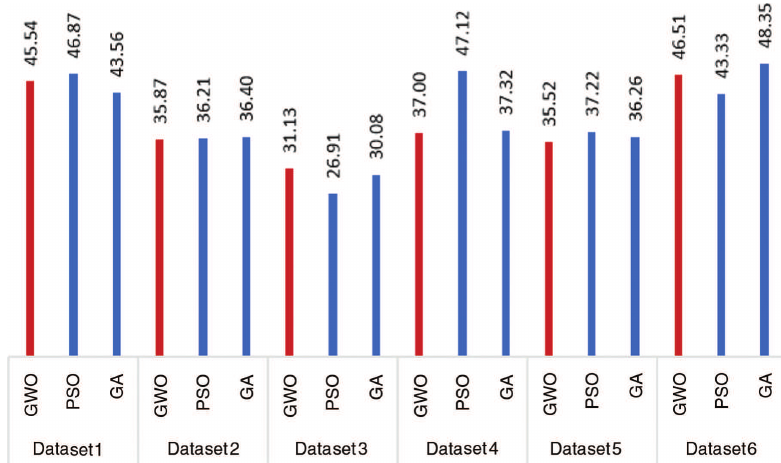
Figure 7: Results of Time Complexity. Table 3: Results of the Wilcoxon Statistical